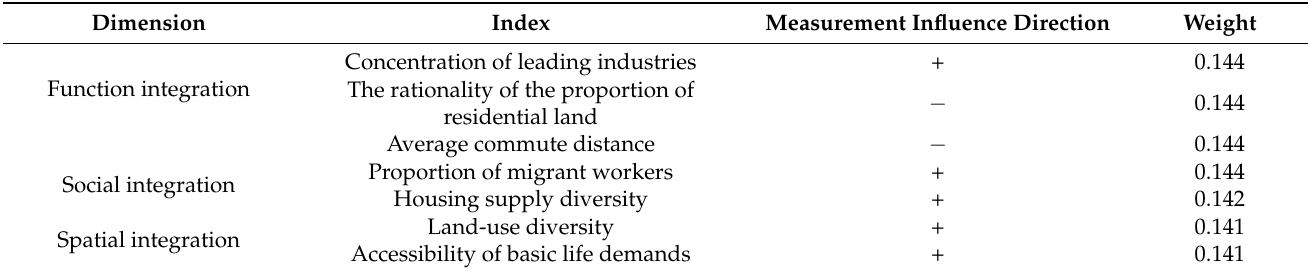
Table 5. The weight results of the Kangqiao industrial